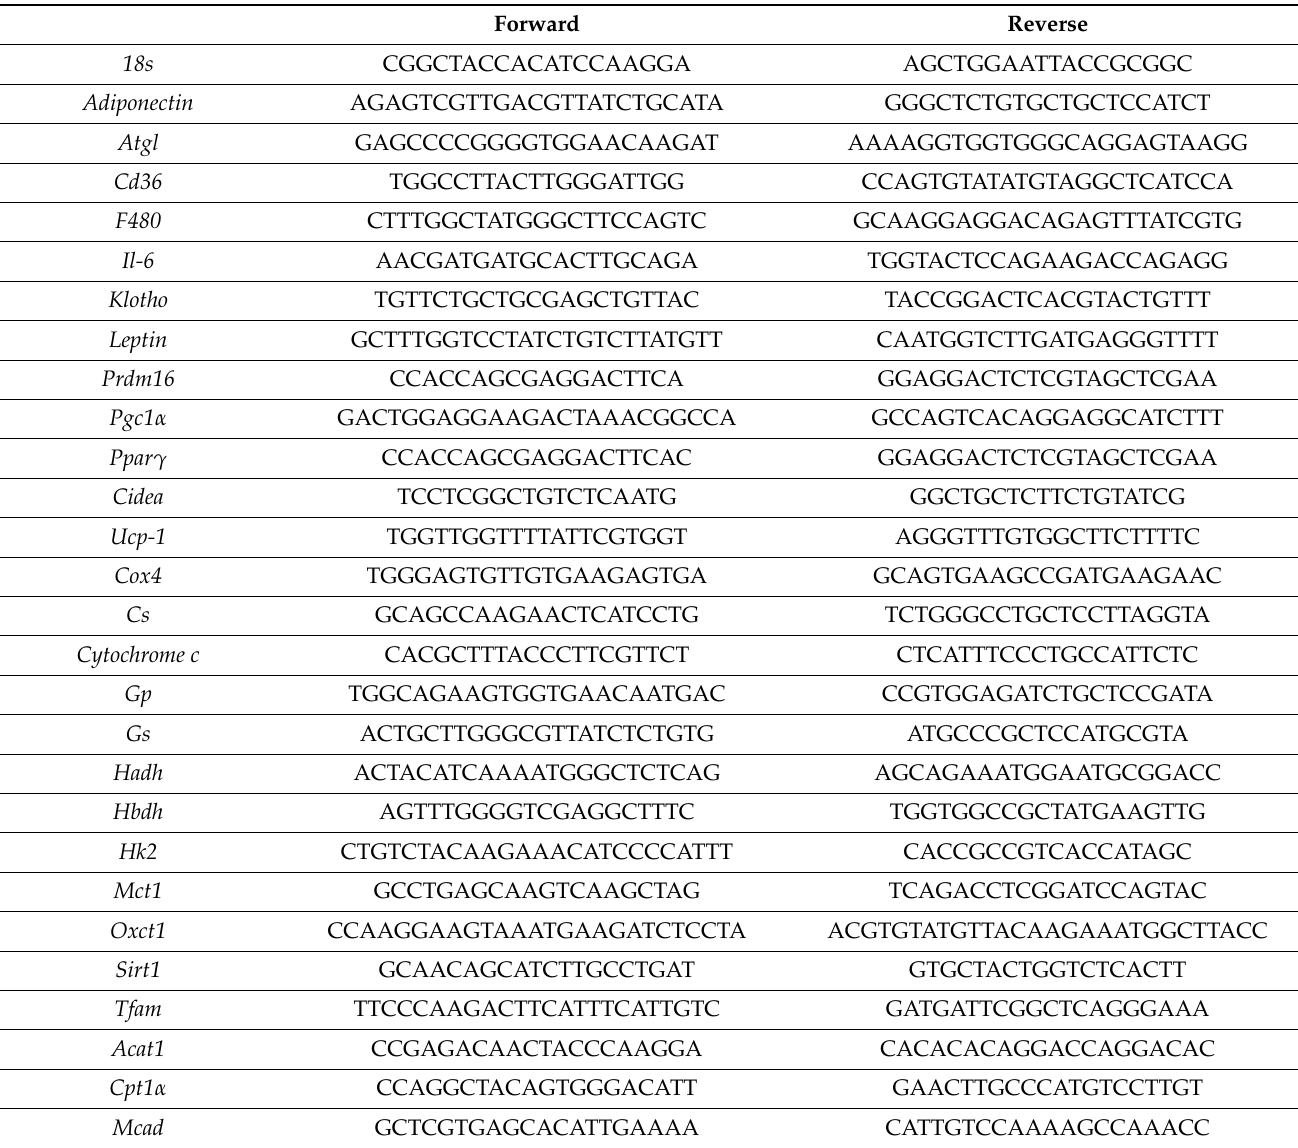
Table 2. List of primers used for real-time